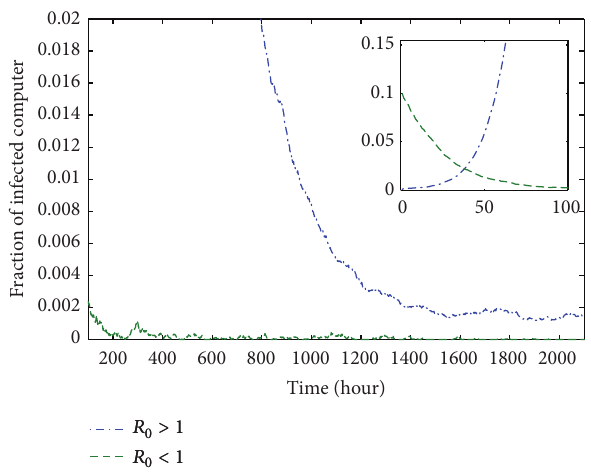
Figure 1: The change figure of proportion of infected computers with time 𝑡 when 𝑅 0 𝑖 < 1 and 𝑅 0 𝑖 > 1 , respectively.